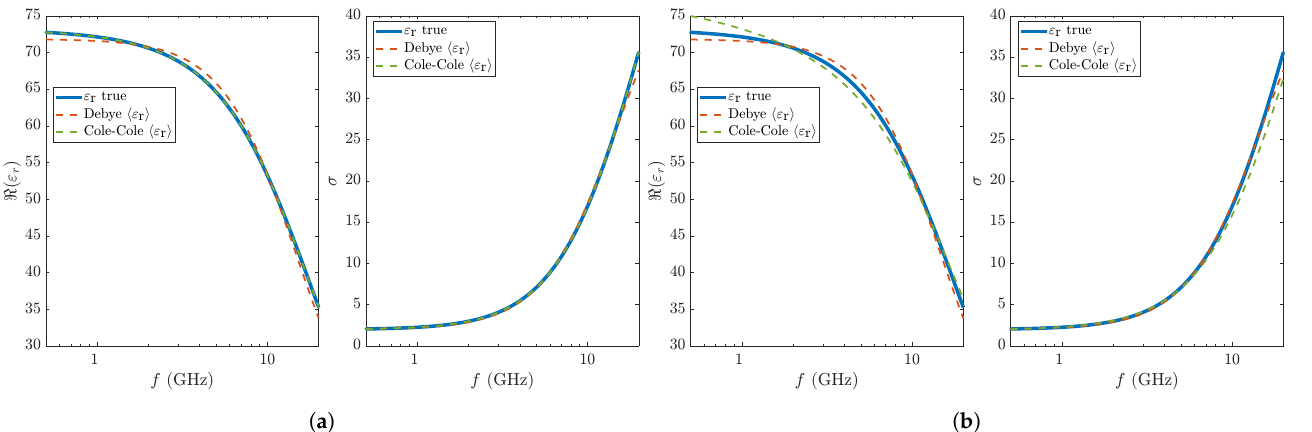
Figure 4. Real part of relative permittivity and conductivity of synthetic data (250 mg/dL glucose concentration) and Debye’s and Cole–Cole’s fitted curves. LMA ( a ) and VPA ( b ) with Set B of initial points are used.